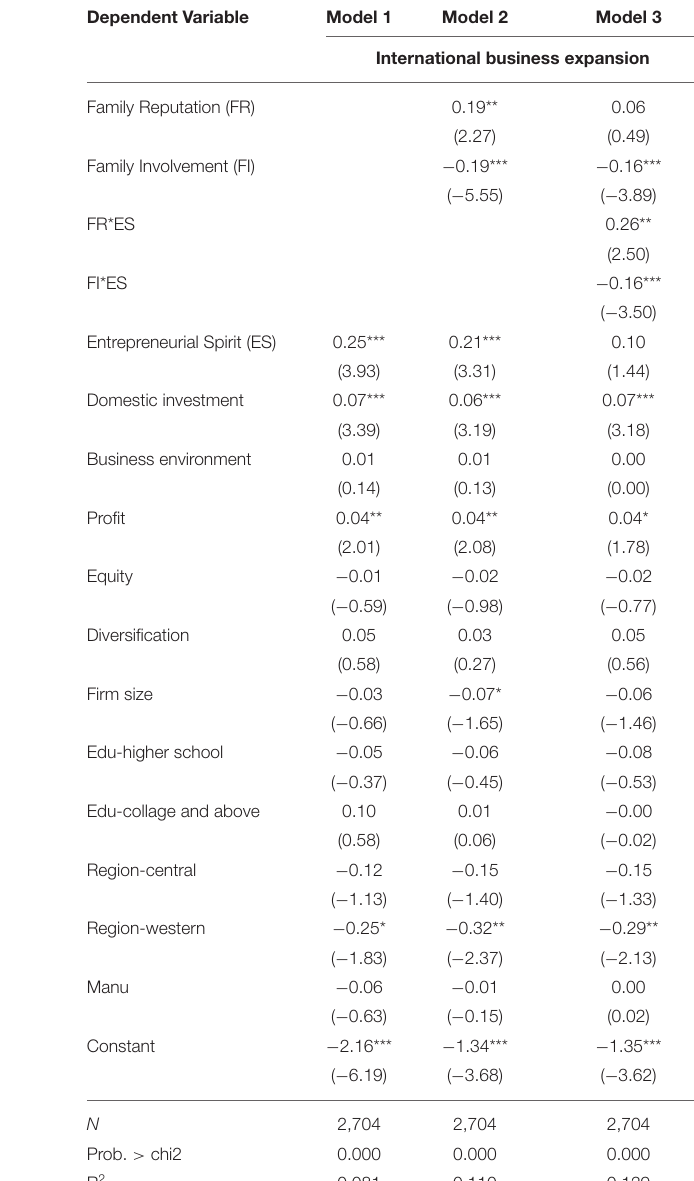
TABLE 3 | Probit model for foreign investment of Chinese small family